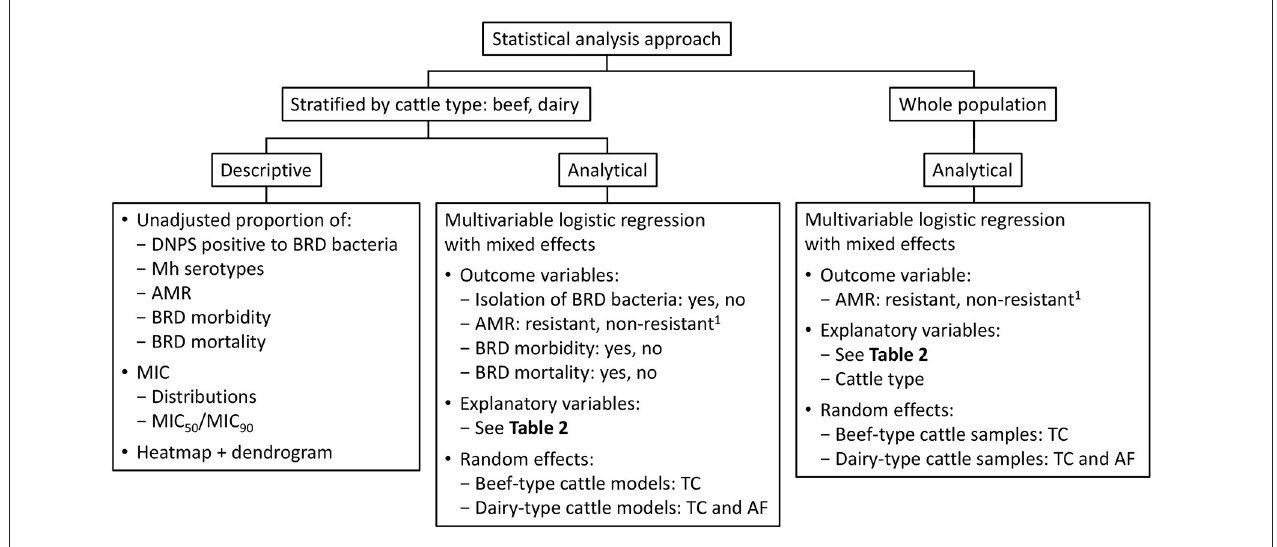
FIGURE 1 | Statistical analyses used in the present study. 1 Non-resistant category includes intermediate and susceptible categories. AF, arrived from; AMR, antimicrobial resistance; BRD, bovine respiratory disease; DNPS, deep nasopharyngeal swab; Mh, Mannheimia haemolytica ; MIC, minimum inhibitory concentration; TC, truck